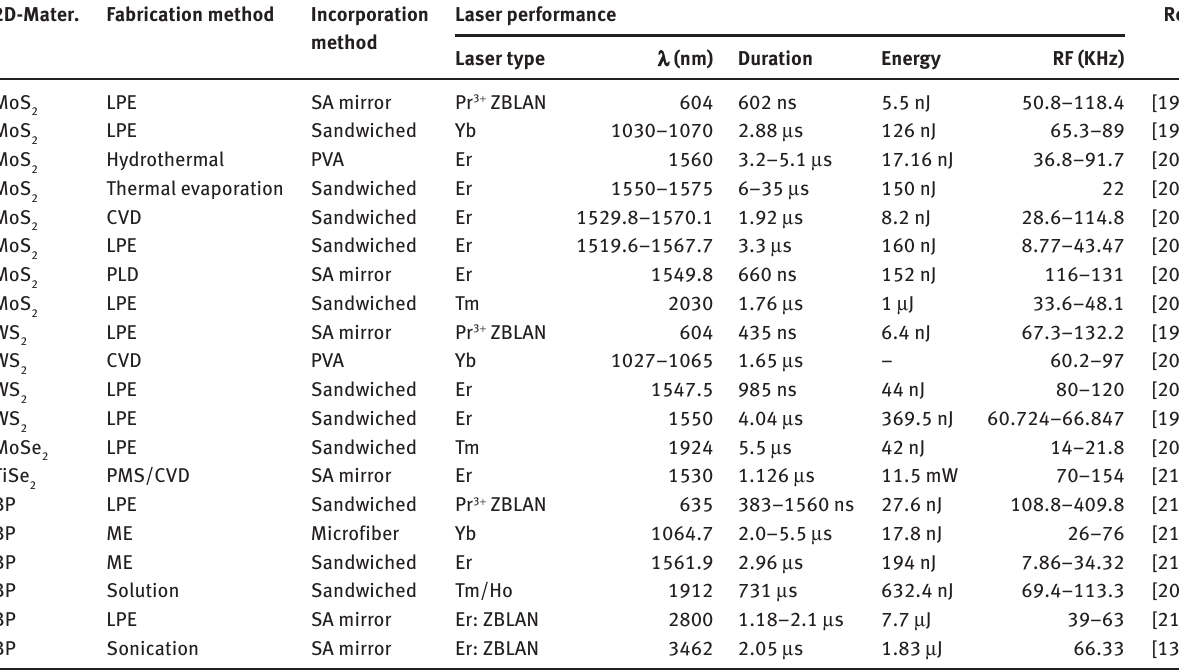
Table 5: Summarization of Q-switched fiber lasers based on transition-metal dichalcogenides (TMDCs) and black phosphorus (BP) saturable absorbers (SAs).